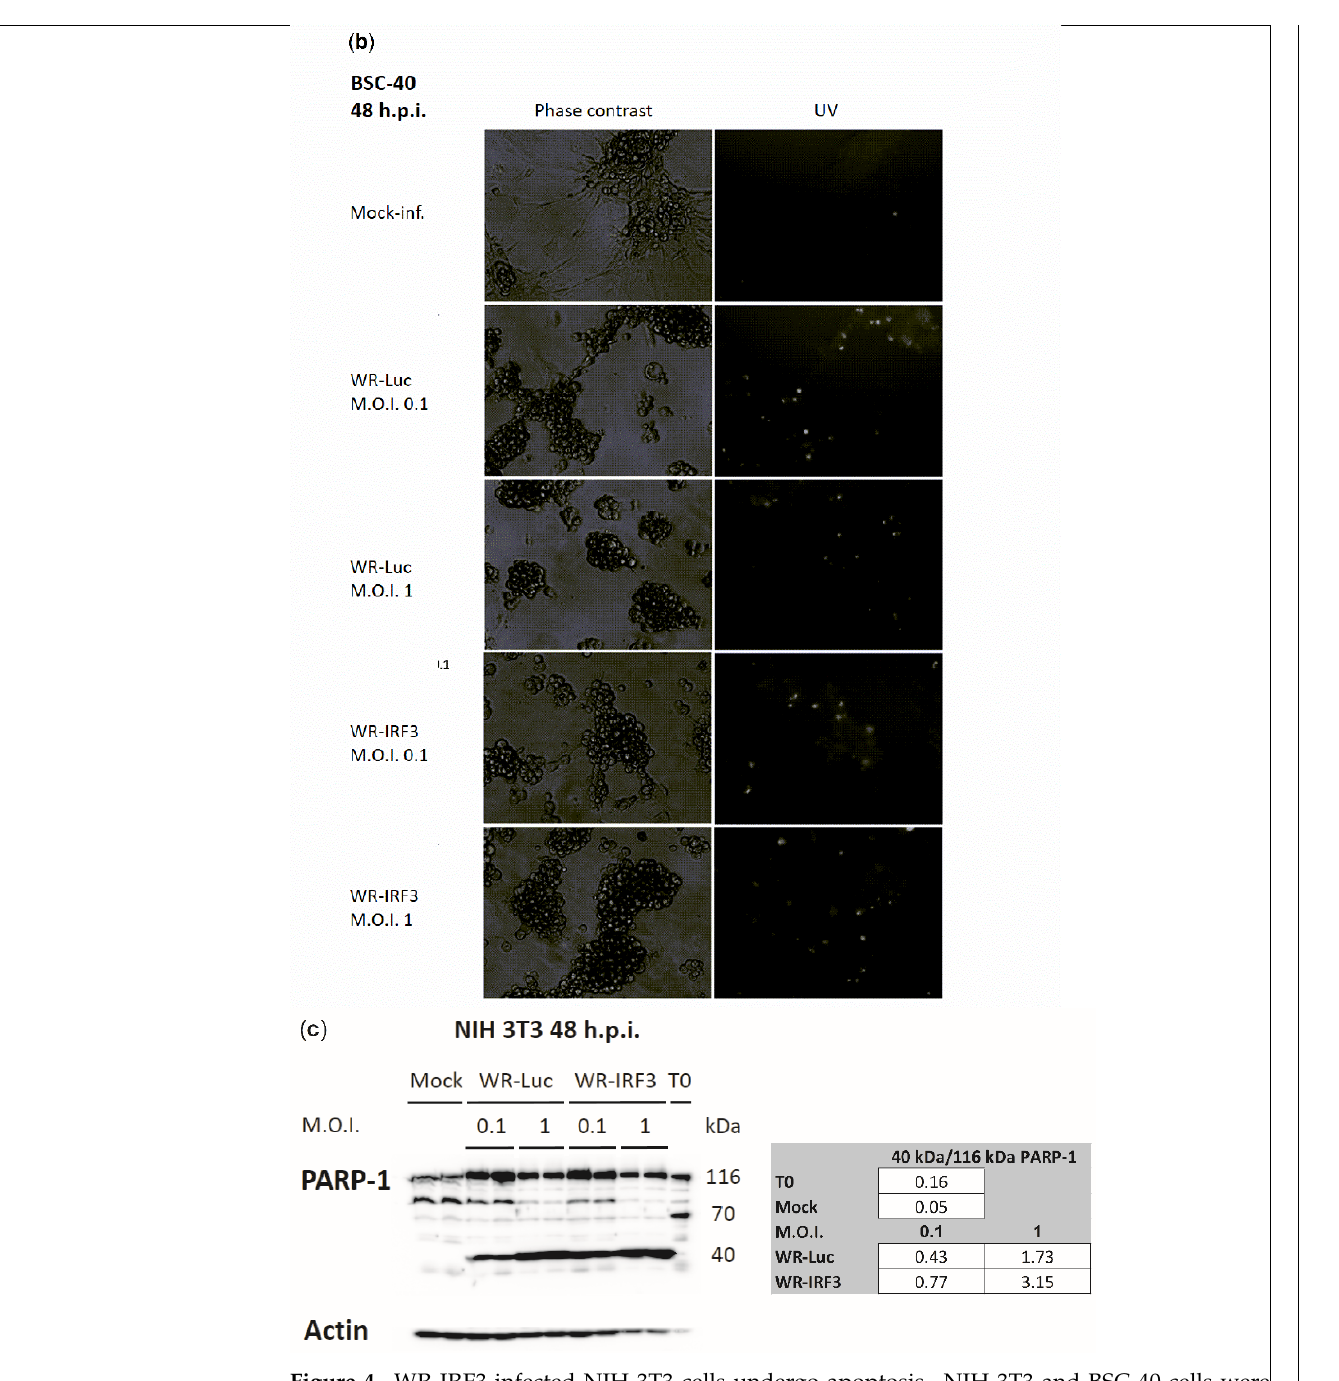
Figure 4. WR-IRF3-infected NIH 3T3 cells undergo apoptosis. NIH 3T3 and BSC-40 cells were mock-infected or infected with WR-Luc or WR-IRF3 at M.O.I. of 0.1 or 1. ( a , b ) Microscopy. At 48 h.p.i., Hoechst 33342 was added to the culture media and the phase contrast and UV-fluorescent pictures were captured at original magnification 150 × . ( c ) PARP-1 cleavage in VACV-infected cells. At 48 h.p.i., the cells were collected and the cell lysates were resolved by 8% SDS-PAGE. PARP-1 cleavage and control β -actin were detected by western blot analysis and chemiluminescence. Mock, mock-infected cells; WR-Luc, cells infected with VACV expressing luciferase; WR-IRF3, cells infected with VACV expressing Mu IRF-3; T0, time of infection.